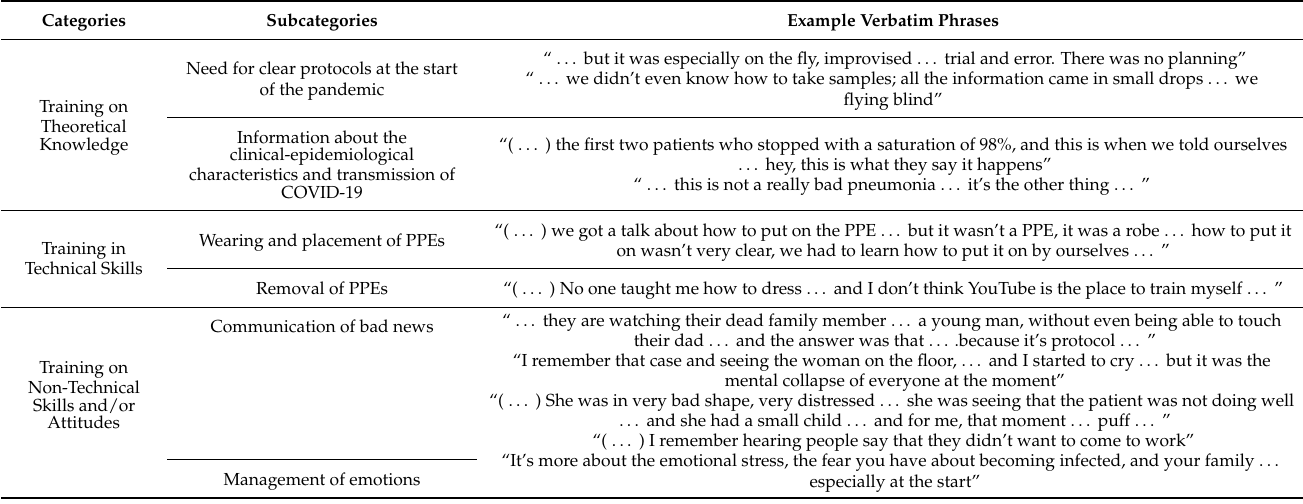
Table 5. Categories and sub-categories of the ICU focus